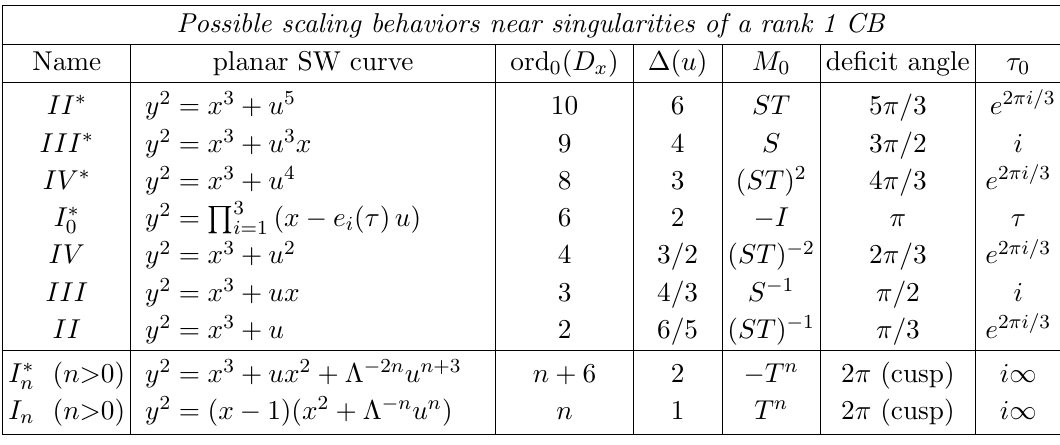
Table 2 . Scaling forms of rank 1 planar special K(cid:127)ahler singularities, labeled by their Kodaira type (column 1), a representative family of elliptic curves with singularity at u = 0 (column 2), order of vanishing of the discriminant of the curve at u = 0 (column 3), mass dimension of u (column 4), a representative of the SL(2 ; Z ) conjugacy class of the monodromy around u = 0 (column 5), the de(cid:12)cit angle of the associated conical geometry (column 6), and the value of the low energy u(1) coupling at the singularity (column 7). The (cid:12)rst seven rows are scale invariant. The last two rows give in(cid:12)nite series of singularities which have a further dimensionful parameter (cid:3) so are not scale invariant; they are IR free since (cid:28) 0 = i 1